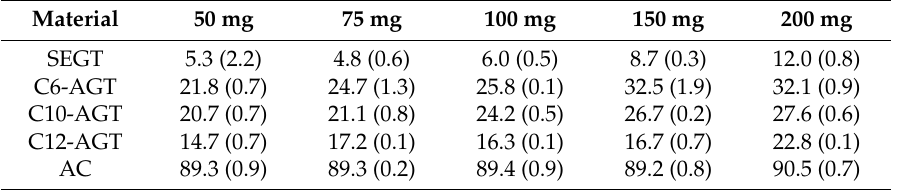
Table 3. Percentages of 2-CP removed from a 50 ppm solution using varying masses of adsorbent.